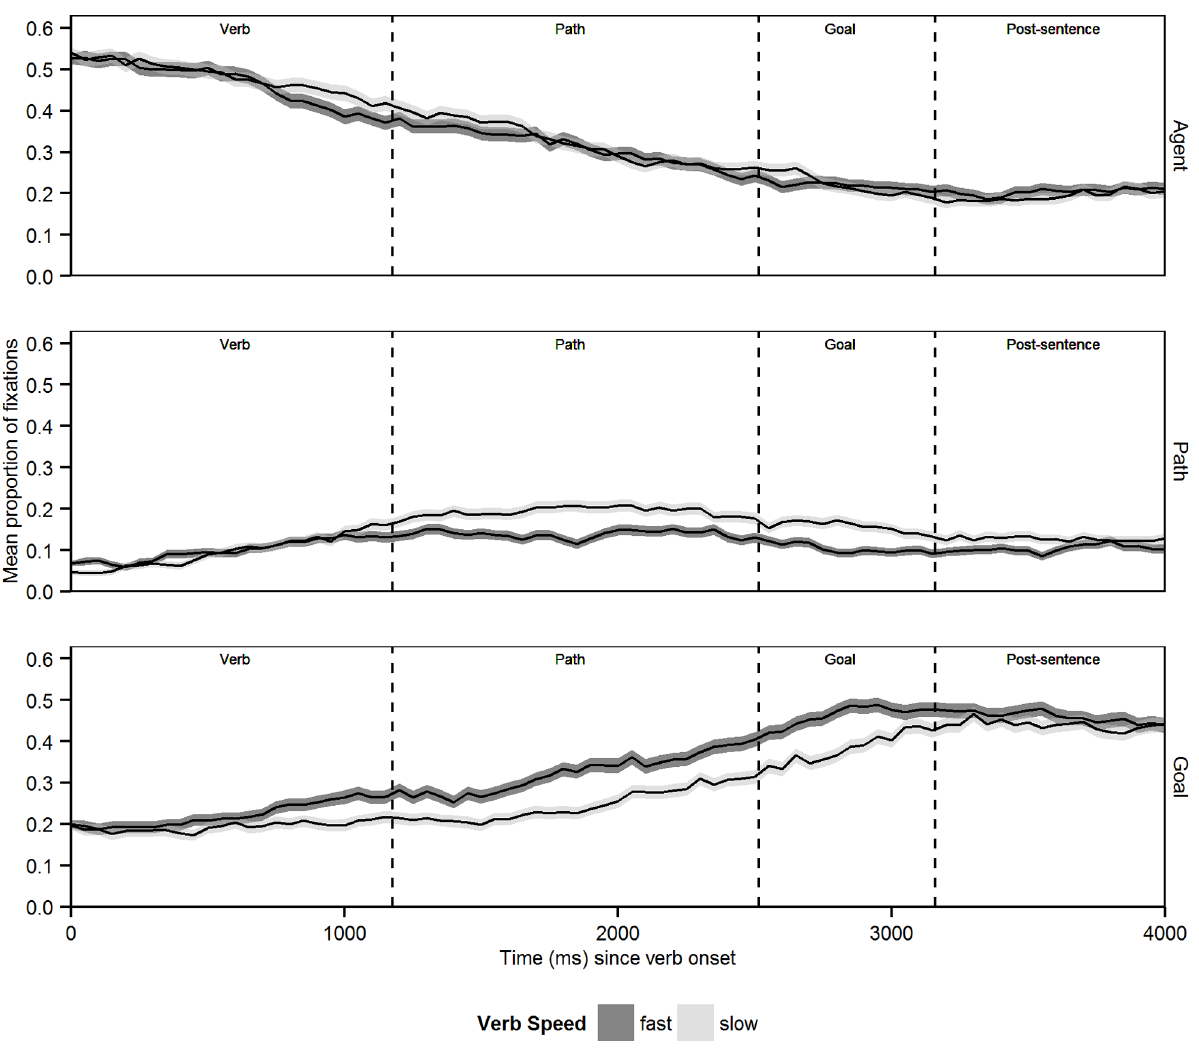
Figure 4. Mean proportions of fixations for Agent, Path and Goal regions, where 0 ms=verb onset. Shaded area around mean line indicates 1 6 std. error from the mean.